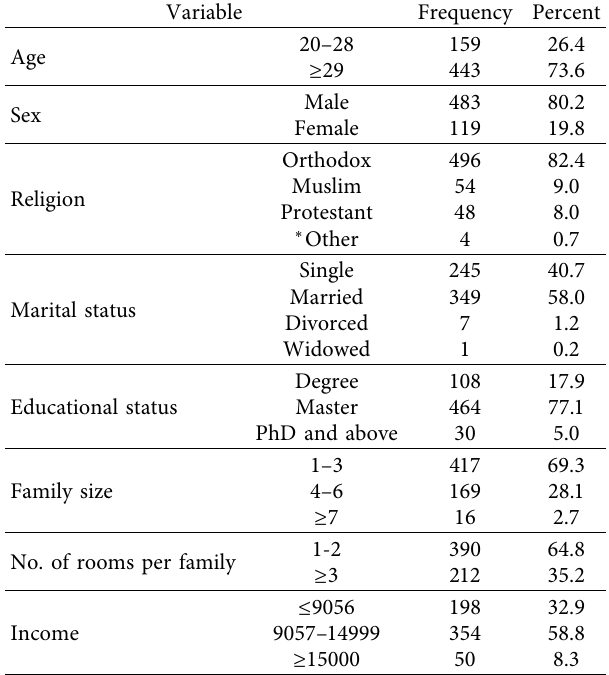
Table 2: Magnitude of COVID-19-related perception of the aca- Table 1: Sociodemographic characteristics of academic staff of